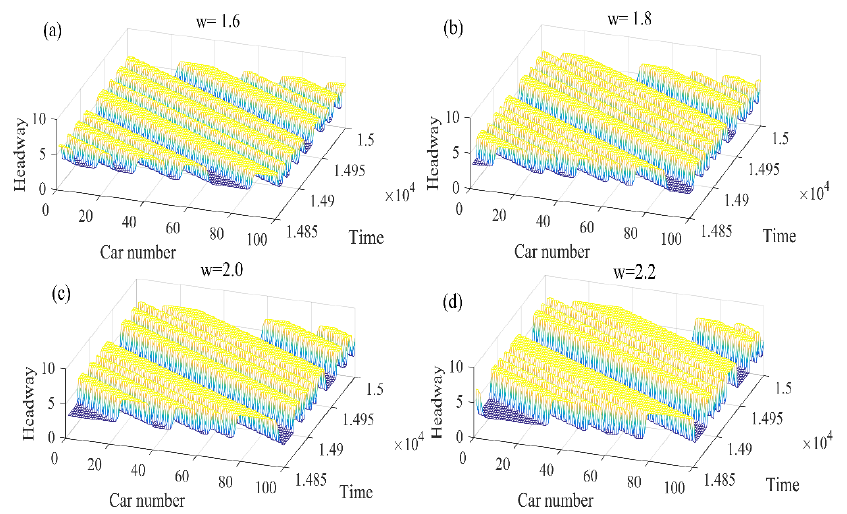
14800 t = 15000 to with